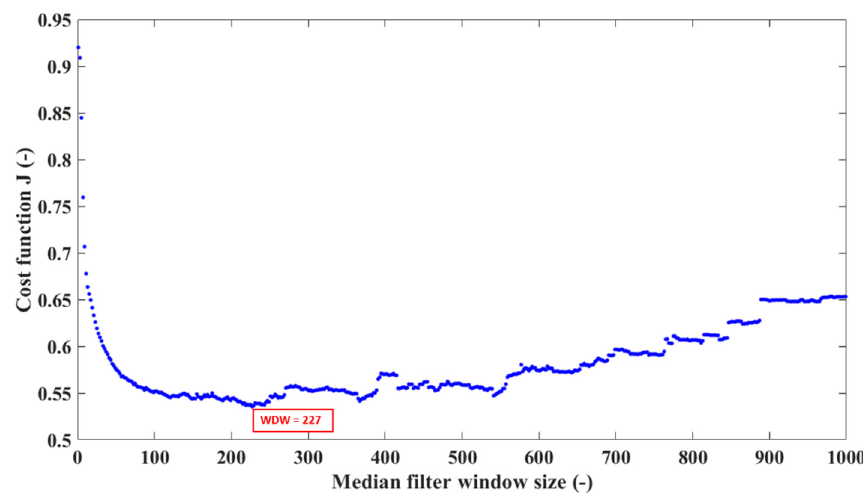
Figure 6. Estimating the optimal window size of the median filter by minimizing the cost function J. The optimal median filter window size (WDW) was 227 samples.